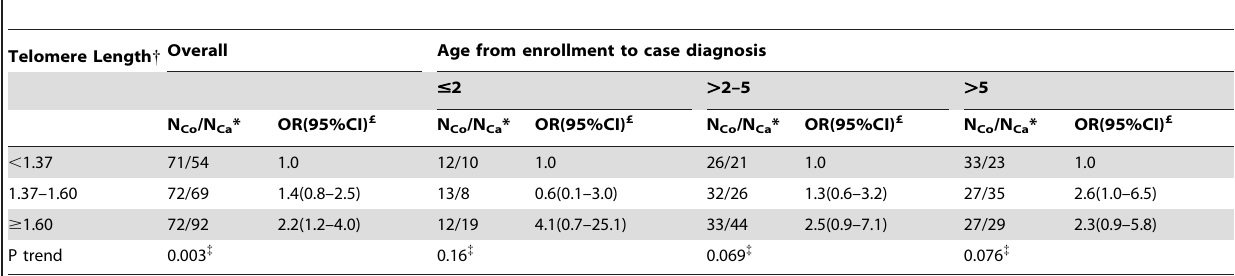
Table 2. Telomere length and risk of lung cancer: results for overall study and stratifying by years from enrollment to case diagnosis.